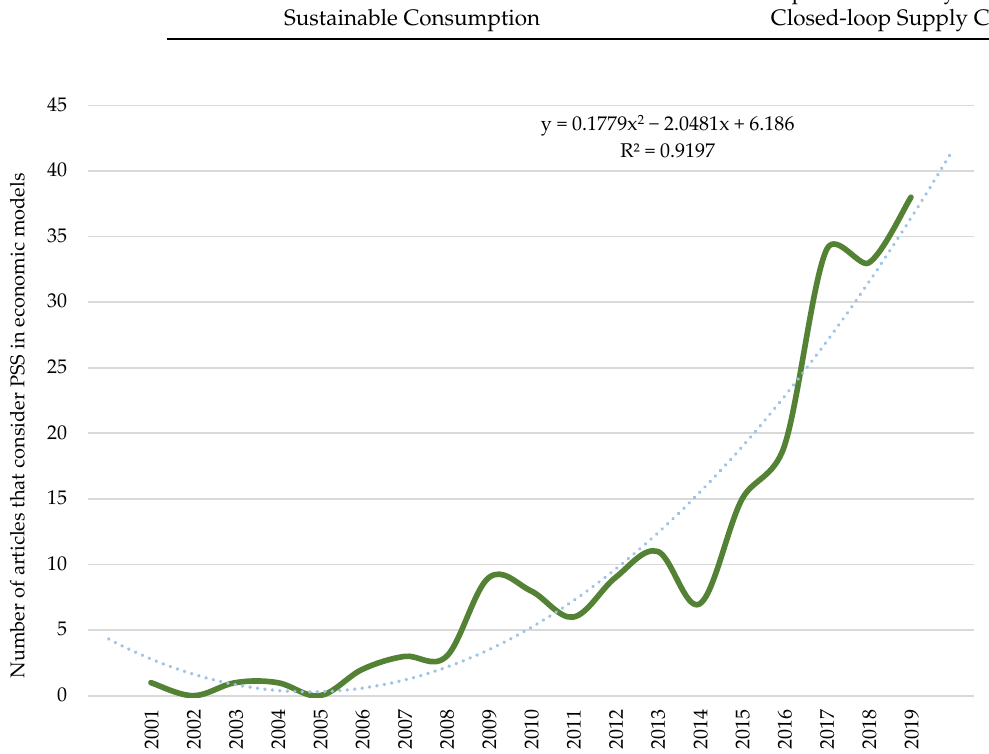
Figure 13. Research on the economic dimension of PSS.